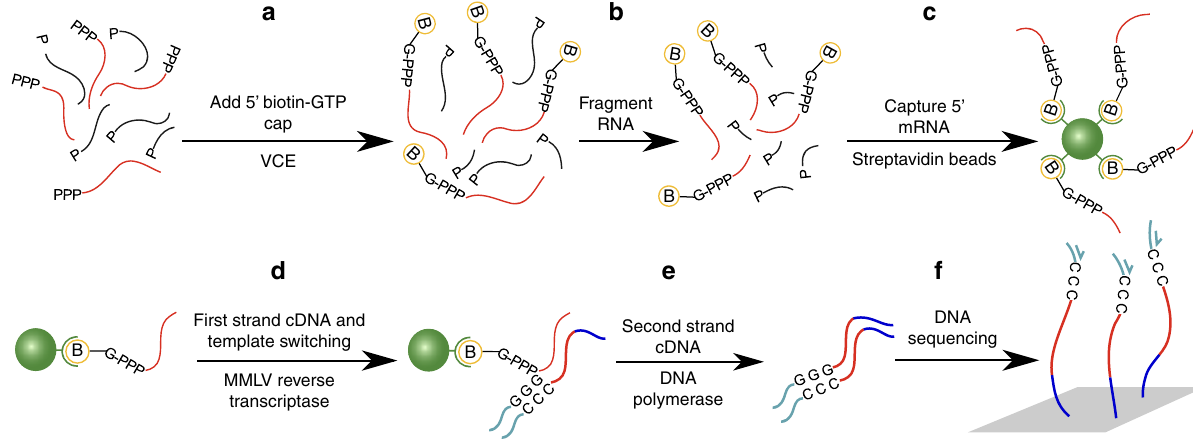
Figure 1 | Overview of the Capp-Switch sequencing approach. Capp-Switch includes ( a – c ) capture of 5 0 mRNA fragments and ( d – f ) cDNA synthesis and sequencing. ( a ) The mRNA 5 0 triphosphate is capped with biotin-GTP by VCE. ( b ) RNA is fragmented and ( c ) the capped 5 0 mRNA fragments are captured on streptavidin magnetic beads and separated from other RNA. ( d ) The 5 0 mRNA fragments are reverse transcribed to single-stranded cDNA using MMLV reverse transcriptase. An oligonucleotide hybridizes to the 3 0 overhang and the complementary sequence is synthesized by the MMLV template-switching activity. ( e ) Double-stranded cDNA is synthesized using primers that hybridize to the single-stranded cDNA termini. ( f ) The cDNA is sequenced on a high- throughput